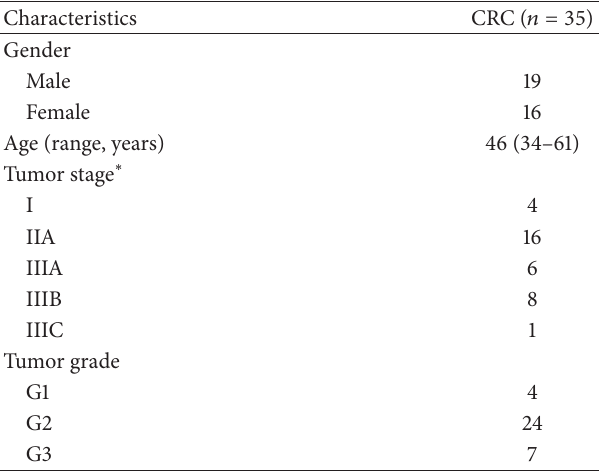
Table 1: Clinicopathologic information of colorectal cancer